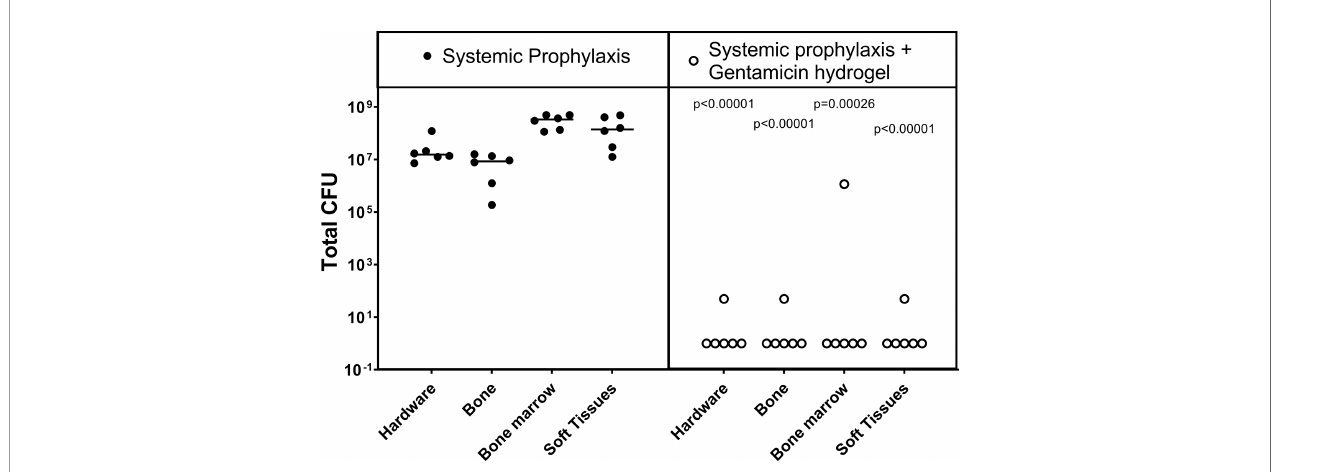
FIGURE 1 | Bacteriology at euthanasia in the prophylaxis model. CFU counts were obtained from individually collected tissue samples taken postmortem and individually processed. Gentamicin hydrogel was applied immediately before wound closure. Statistical comparisons are per location for each group, n= 6 per group. Lines represent median values, statistical comparison by two-sided T-test of Log transformed